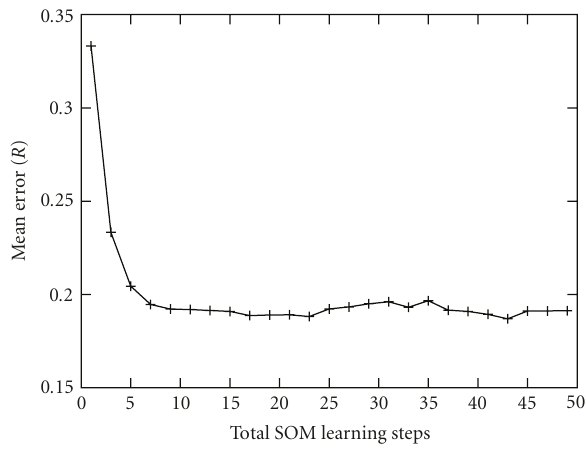
Figure 7: Performace by SOM learning